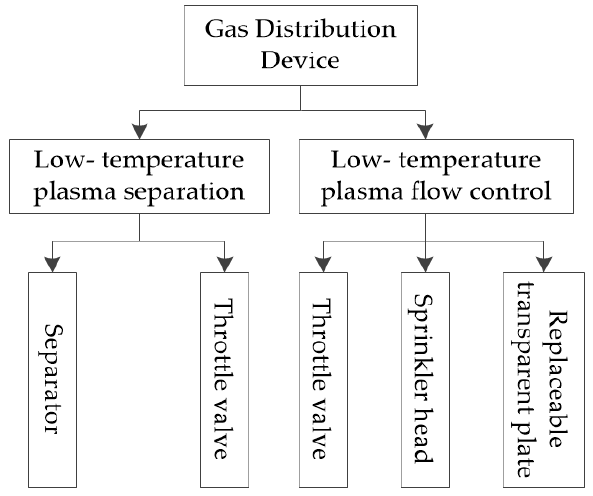
Figure 5. The functional structure tree of the gas distribution device. The design scheme of the secondary gas distribution device is formed through the further sustainable modular innovative design. Among them, the first-stage gas distribu- tion device is composed of an upper gas distribution plate, a partition plate, and many throttle valves, which are used to control the plasma to enter different regions of the reac- tion chamber. The second-stage gas distribution device is composed of a lower gas distri- bution plate, sprinkler head devices, and many throttle valves, which are used to control the flow rate of the plasma to enter the reaction chamber. Ultimately, the plasma entering the reaction chamber becomes more uniform and the phenomenon of uneven film quality caused by gas recirculation is reduced through the control and adjustment of the plasma by the secondary gas distribution device. Figure 6 is a schematic diagram of the assembly of the secondary gas distribution plates. Figure 6. Schematic diagram of the assembly of the secondary gas distribution device.